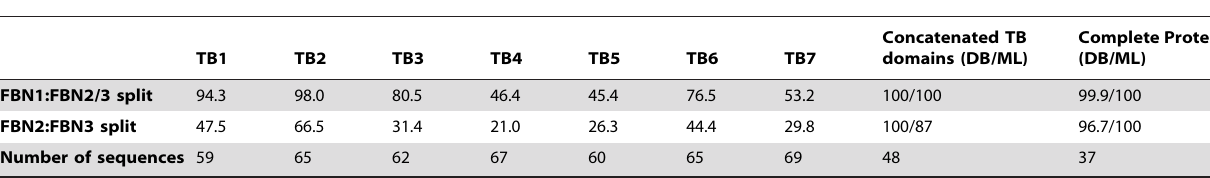
Table 1. Comparison of bootstrap values.